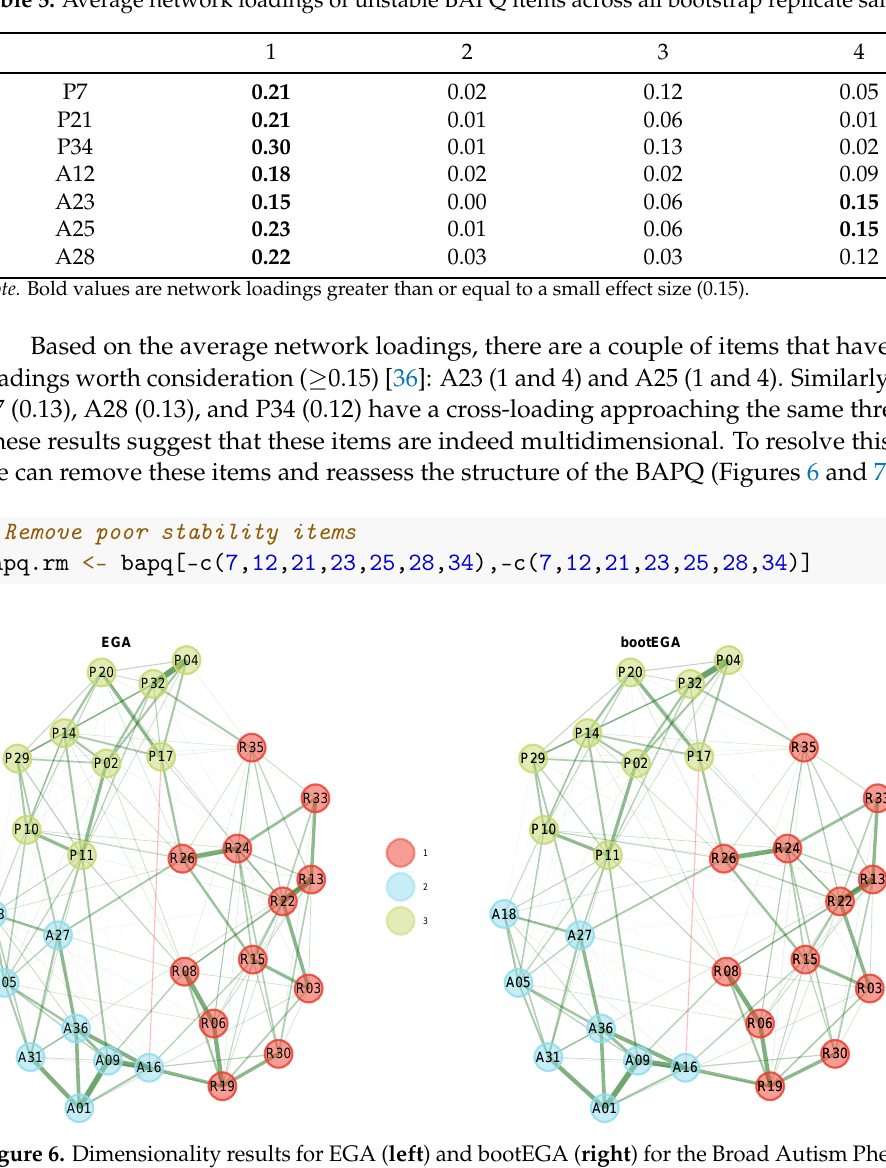
Table 5. Average network loadings of unstable BAPQ items across all bootstrap replicate samples.